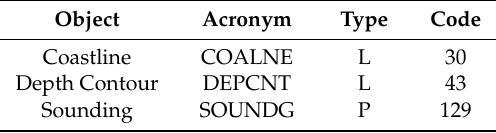
Table 5. ENC elements containing geospatial information used to develop DBSM.